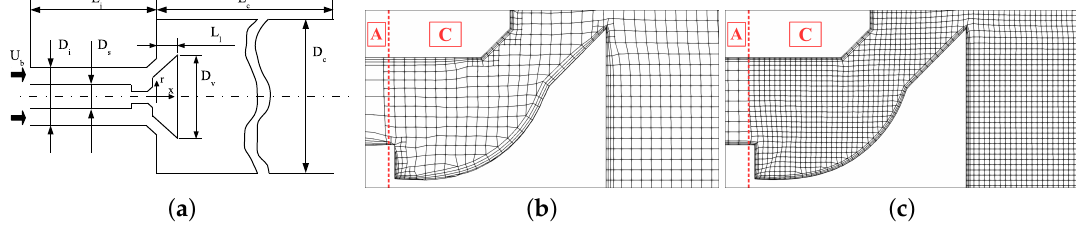
Figure 2. Details of the fixed intake valve case: ( a ) geometrical parameters; ( b ) axial section of mesh 1 with the ZDES modes subdivision; ( c ) axial section of mesh 2 with the ZDES modes